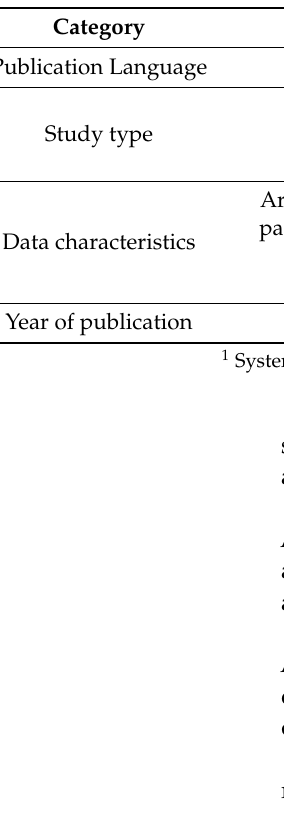
Table 1. Inclusion and exclusion